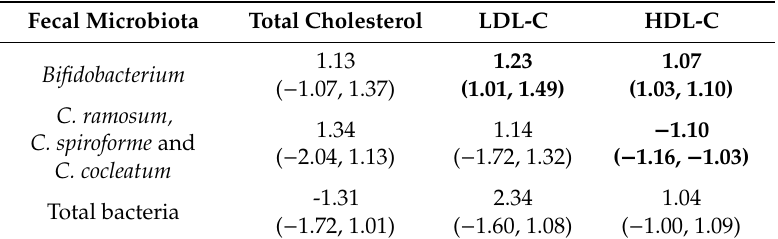
Table 2. Associations between every two-fold increase in the log-transformed fecal microbiota and geometric means 1 (95% confidence intervals) of men’s serum total cholesterol, low density